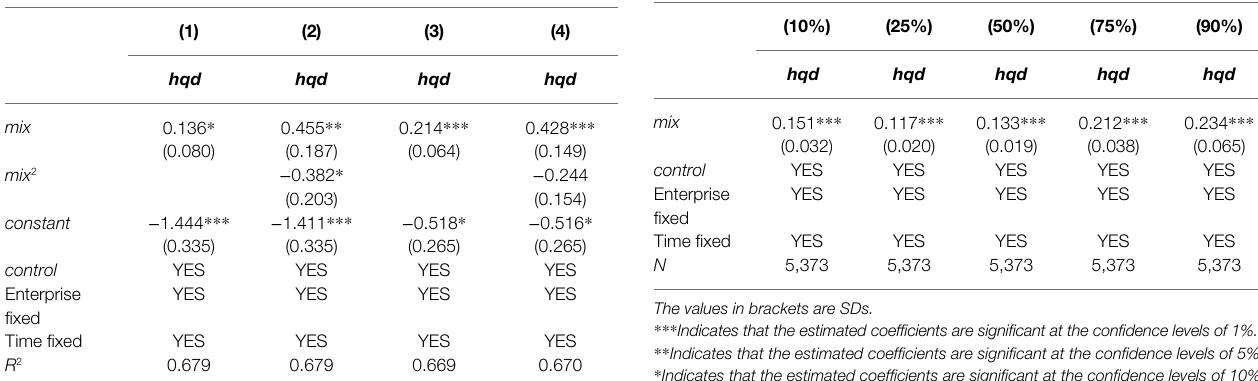
TABLE 9 | The analysis of the industry heterogeneity. TABLE 10 | The analysis of development-level